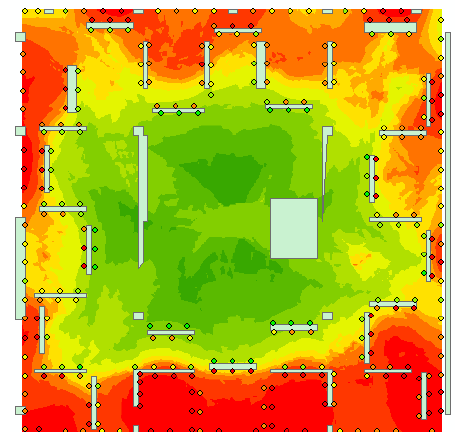
Figure 10. Overall visibility of artworks